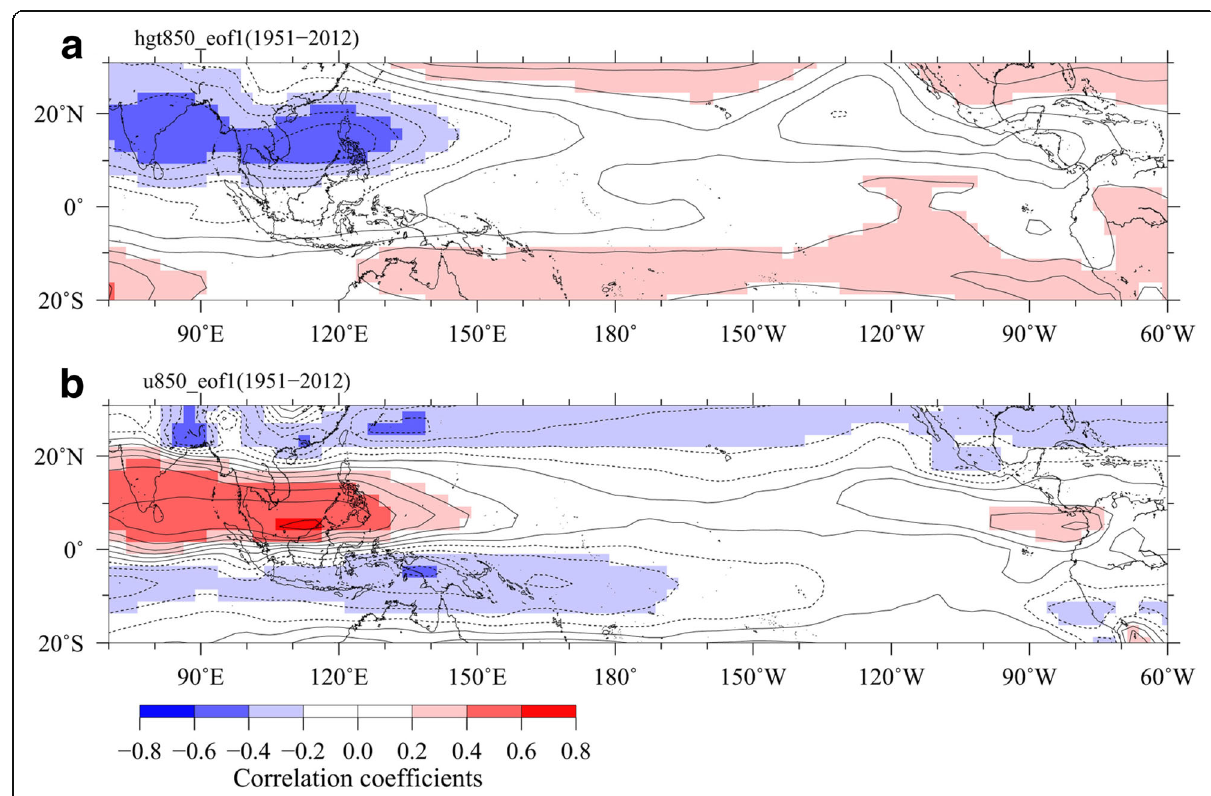
Fig. 6 Correlation maps between the time coefficients of EOF1 and geopotential height ( a ) and zonal component of the wind field ( b ) at the 850 hPa level from 1951 to 2012. The contour interval is 0.1. The solid and dashed lines indicate positive and negative correlation coefficients, respectively. Correlation coefficients above 0.1 or below − 0.1 indicate a significant correlation at the two-sided 99% level according to Student ’ s t